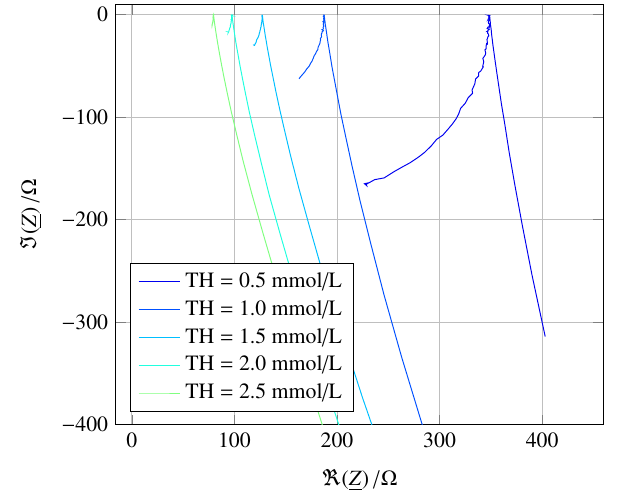
Table 1. List of water samples with a total hardness of